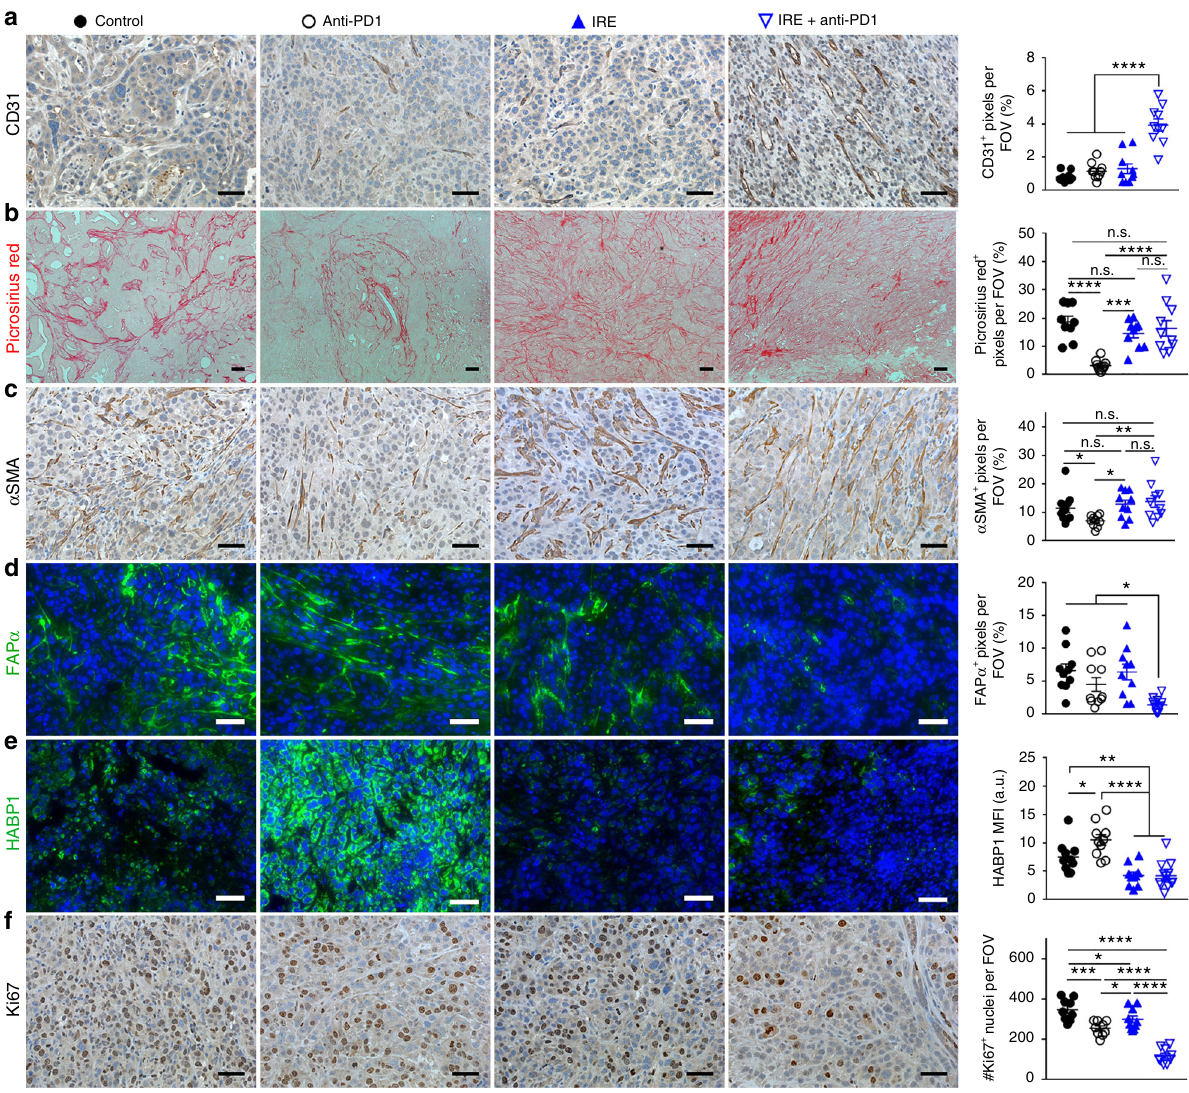
Fig. 7 IHC staining of viable tumor region at 9 days after initiation of treatments. Representative micrographs of staining for CD31 ( a ), Picrosirius Red ( b ), α SMA ( c ), FAP α ( d ), HABP1 ( e ), and Ki67 ( f ) and corresponding quanti fi cations. Ten to fi fteen visual fi elds were randomly captured each group for control (black solid circle), anti-PD1 (black circle), IRE (blue solid triangle), and IRE + anti-PD1 (blue triangle). Scale bars = 50 µ m. Five doses of anti-PD1 had been administered at this time point for the anti-PD1 and combination groups. Data are presented as mean±SEM. Signi fi cance was determined using 1-way ANOVA followed by Tukey post hoc analysis. * p <0.05, ** p <0.01, *** p <0.001, **** p <0.0001. FOV fi eld of view, n.s. not signi fi cant. Source data are provided as a Source Data fi